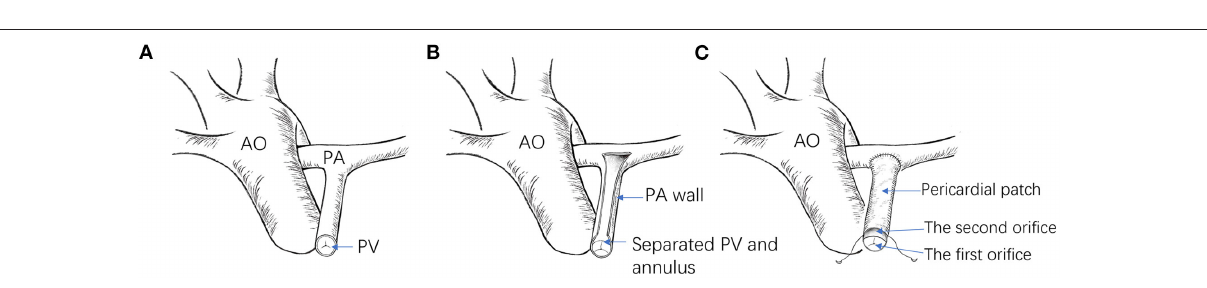
and Log-rank test. Data are expressed as mean alpha level for these analyses was set at p <